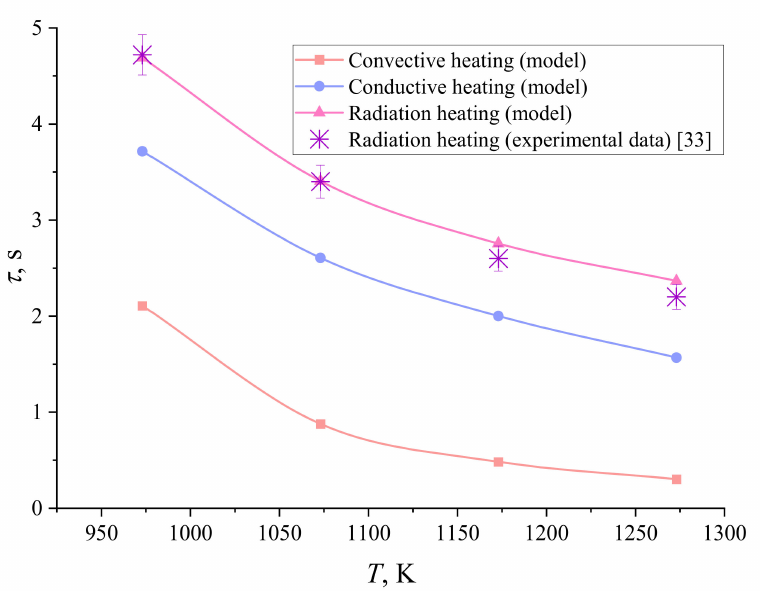
Figure 4. Theoretical and experimental dependencies τ of the gel fuel on T in the conditions of convective, conductive and radiant heating (data from